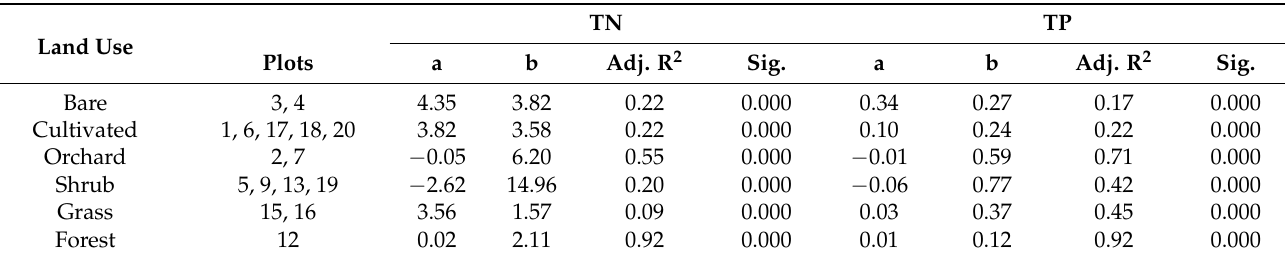
Table 6. Parameters of regression function y = a + b * H between event runoff depth (H) and TN and TP losses from each type of plots during the study period. Note: H represent runoff